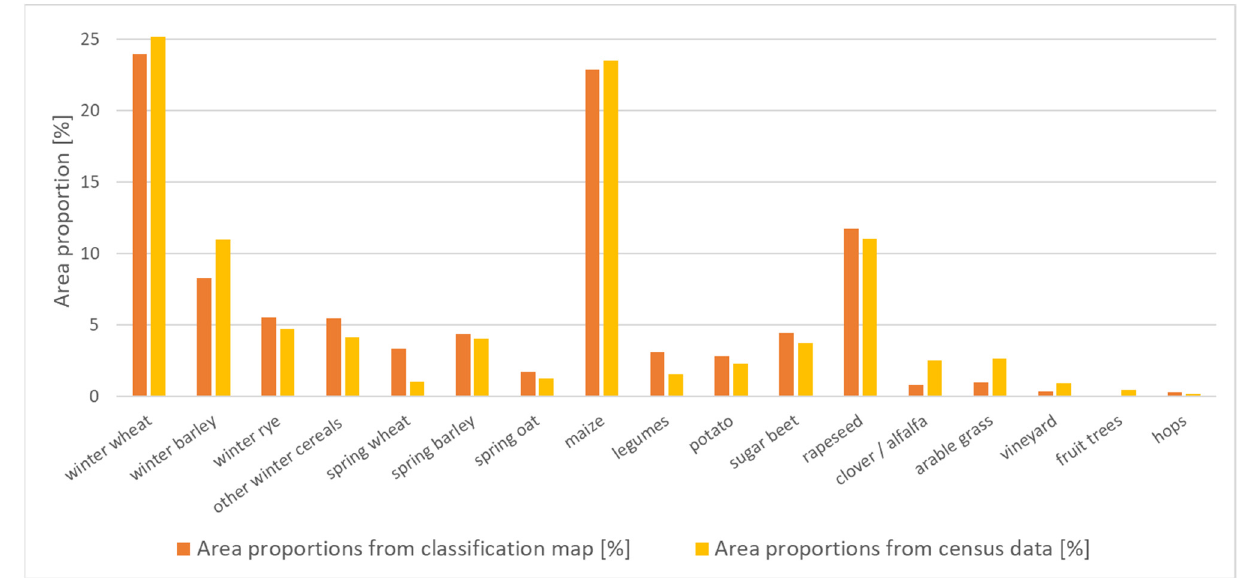
Figure 8. Comparison of area proportions estimated from the 2018 S12 crop type map for Germany to the area proportions as derived from official census data [79–82] (related to the total agricultural area in the respective data set). Table 3. Class-wise F1-scores and overall map accuracies for the landscape regions in Germany, with Northwestern Lowlands—NWL, Northeastern Lowlands—NEL, Western Uplands—WUL, Eastern Uplands—EUL, Southwestern Uplands—SWUL, Alpine Foreland—AFL, and the accuracies of the Germany-wide classification (GER). Light colors indicate a minor deviation ( ≤ 1%) from the Germany-wide classification, while strong colors indicate larger